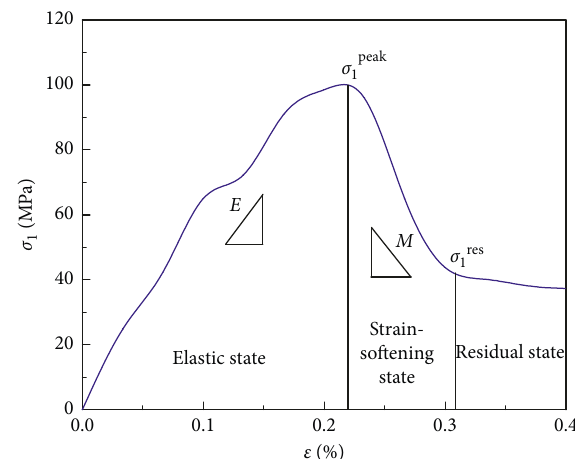
Figure 7: Strain-softening behaviour observed in laboratory tests.